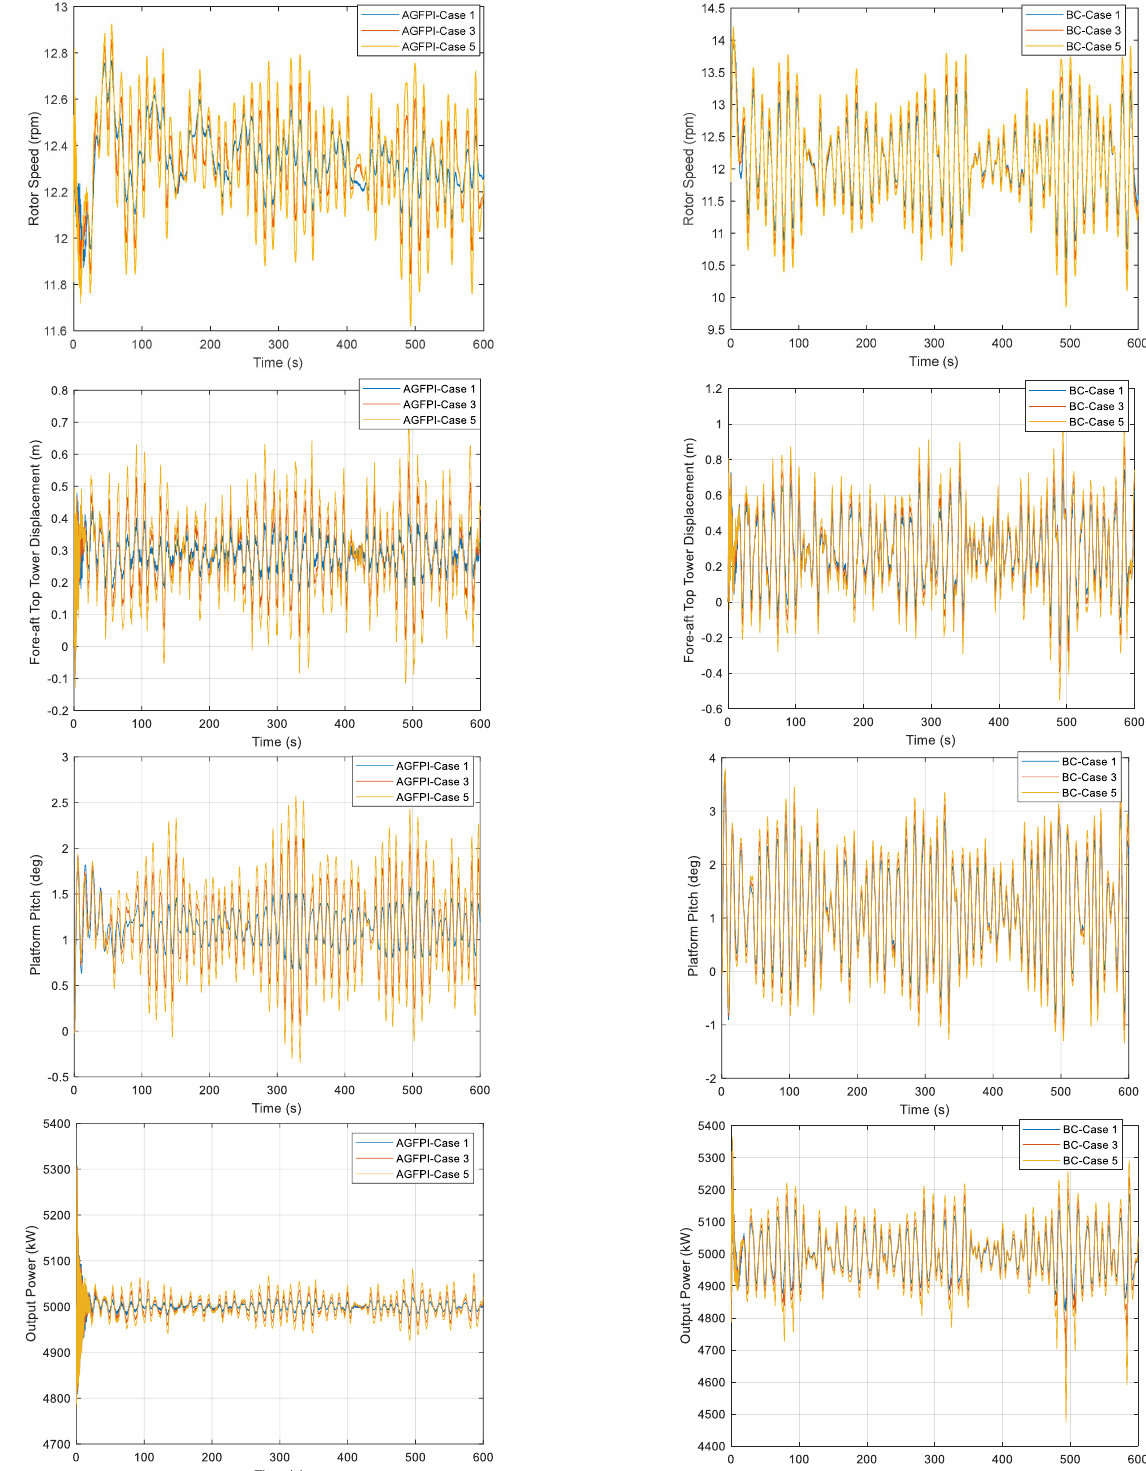
Figure 11. Simulations of tests cases 1, 3, and 5 using the intelligent hybrid controller ( left ) and the FAST controller ( right ).